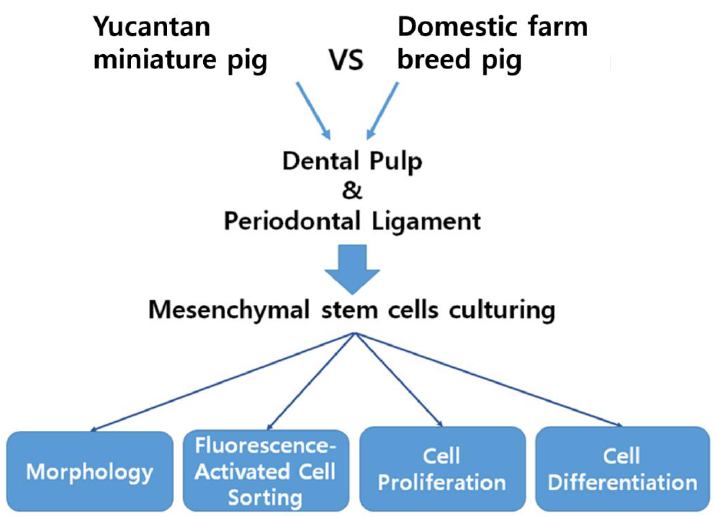
Figure 1. Scheme to compare the characteristics of the dental pulp stem cells (DPSCs) and periodontal ligament stem cells (PDLSCs) of the Yucatan miniature pig breed to those of the domestic farm pig breed.